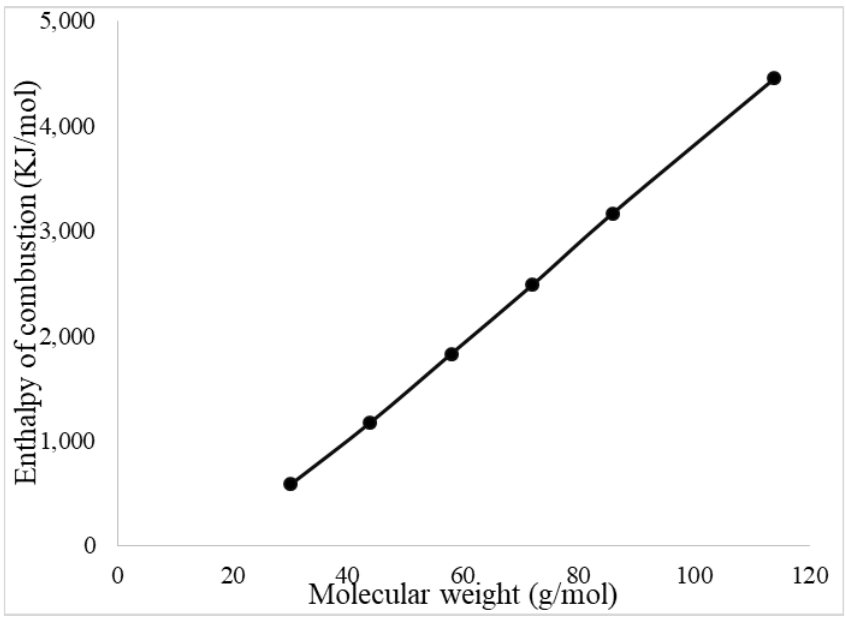
Figure 17. The effect of molecular weight of aldehydes on enthalpy of combustion .